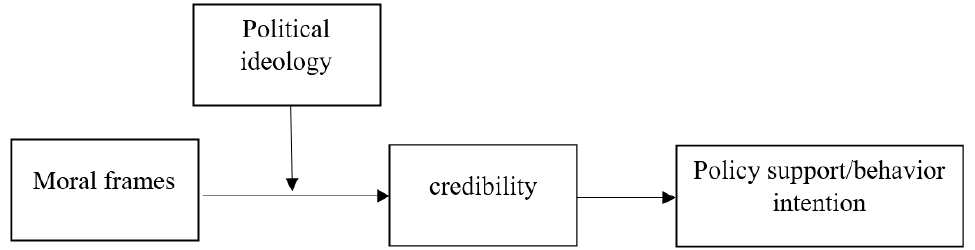
Figure 1. Hypothesized moderated mediation model. Hypothesis 2 (H2). Political ideology moderates the strength of the mediated relationships between moral frames and policy support (H2a) and behavior intention (H2b) via perceived credibility, such that the mediated relationship is stronger in the context of a liberal political ideology than in the context of a conservative political